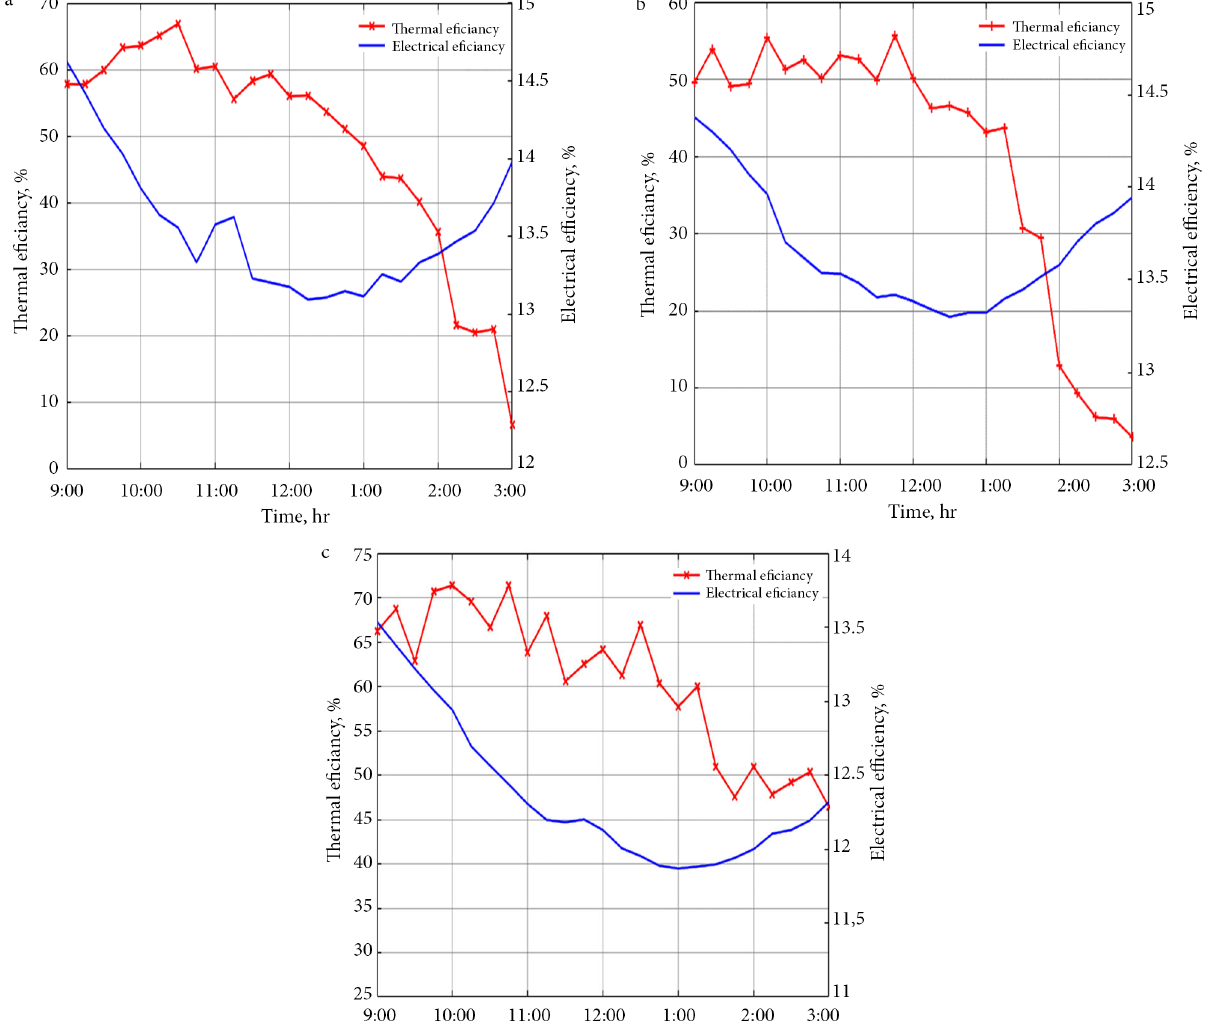
Figure 11. Variation of electrical and thermal efficiency histories on a – Nov. 28 th 2018, b – Feb. 3 rd 2019, c – May 16 th 2019